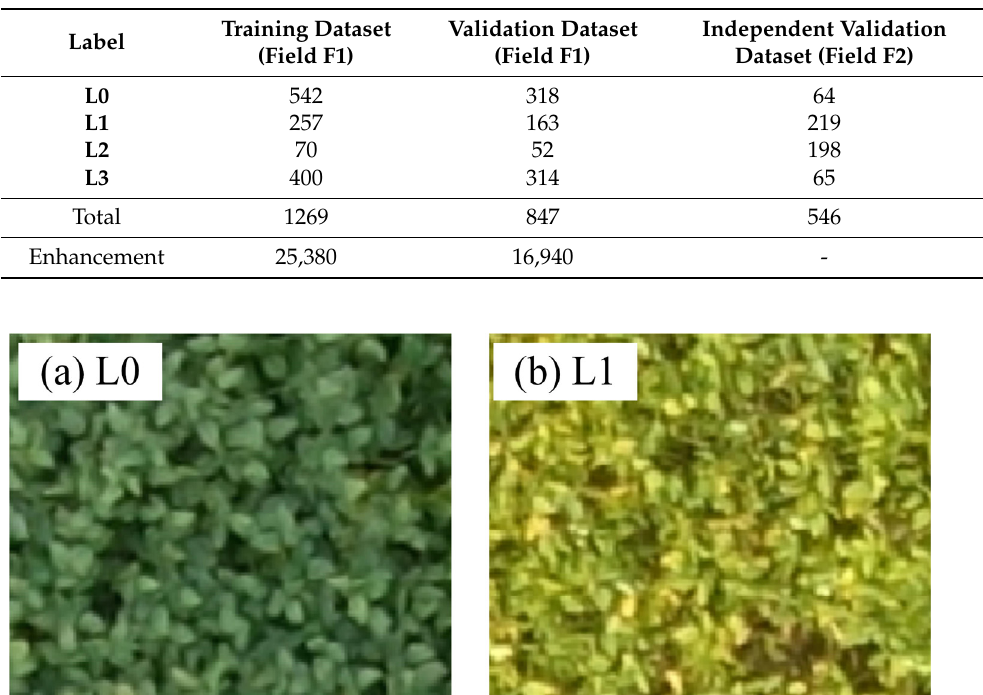
Table 3. Numbers of soybean images for model calibration and validation.